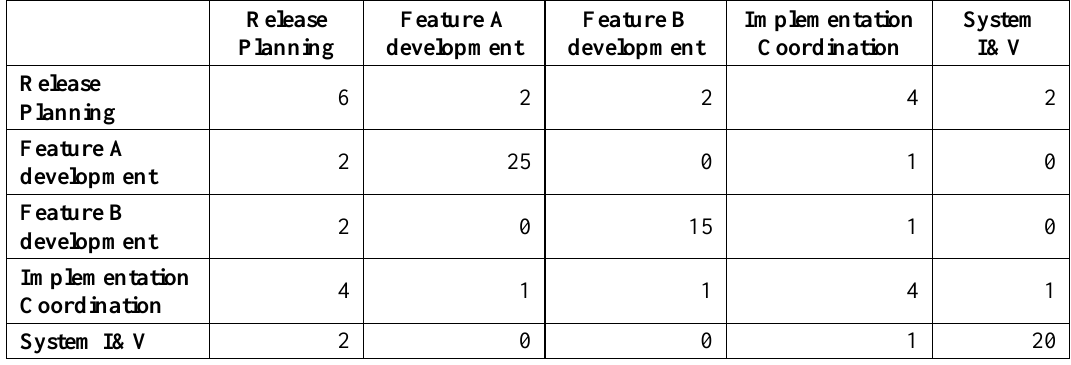
Table 3. An example of the basic team intersection matrix